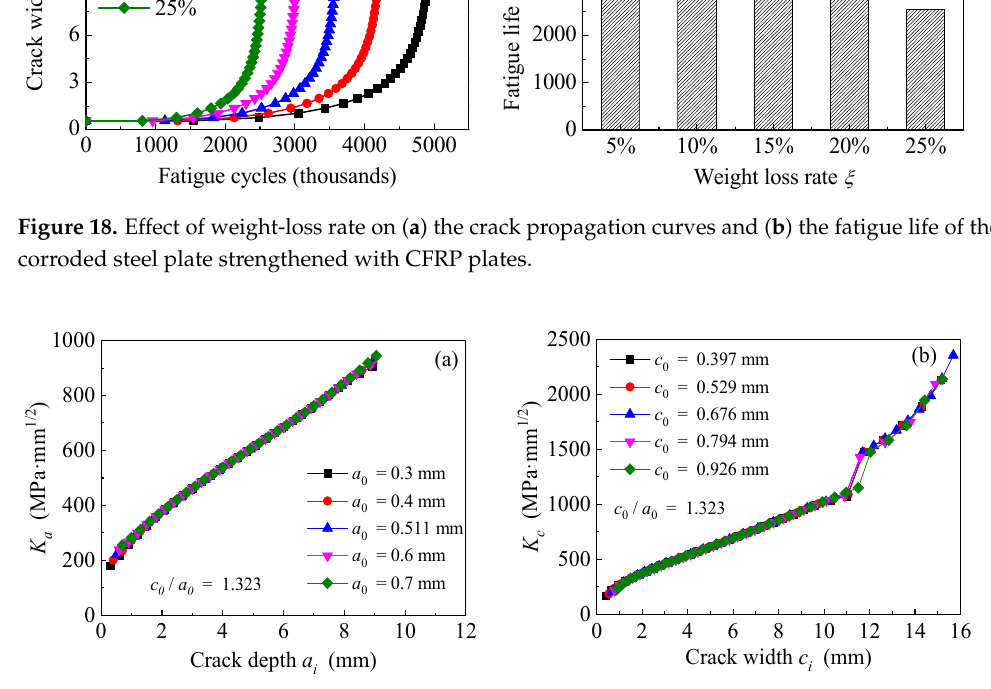
a , and ( b ) K c vs. crack width c . i i